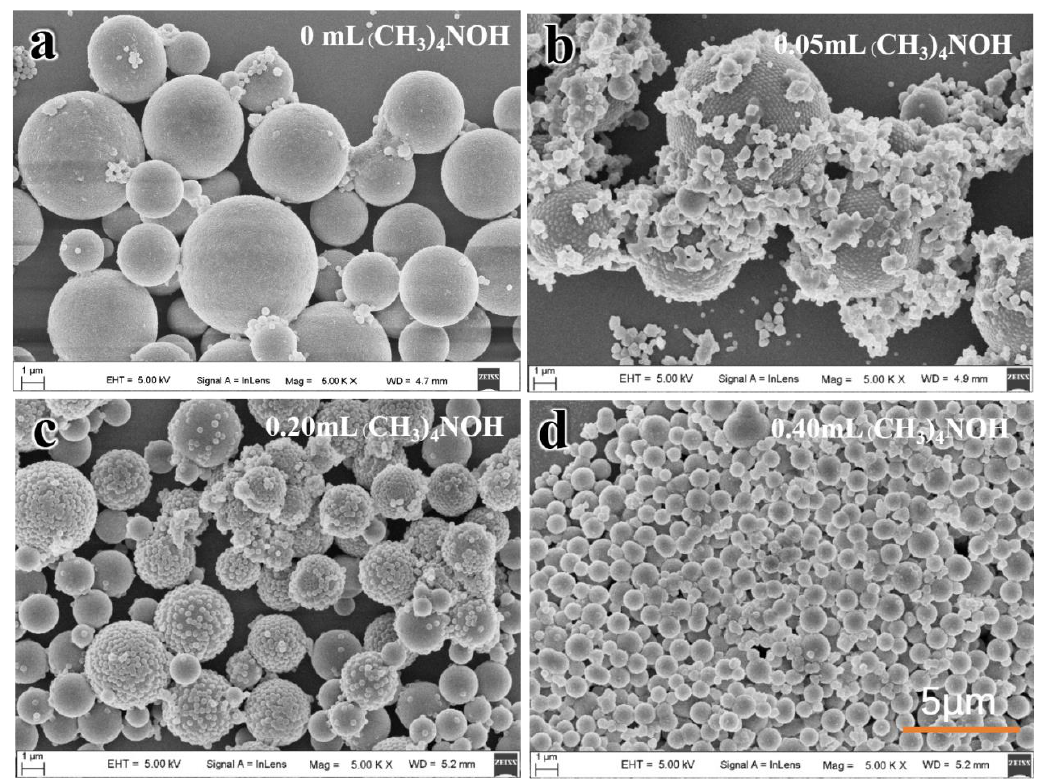
Figure 5. Effects of TMAH contents on the SEM images of HSOS particles; ( a ) 0 mL, ( b ) 0.05 mL, ( c ) 0.20 mL, ( d ) 0.40 mL.